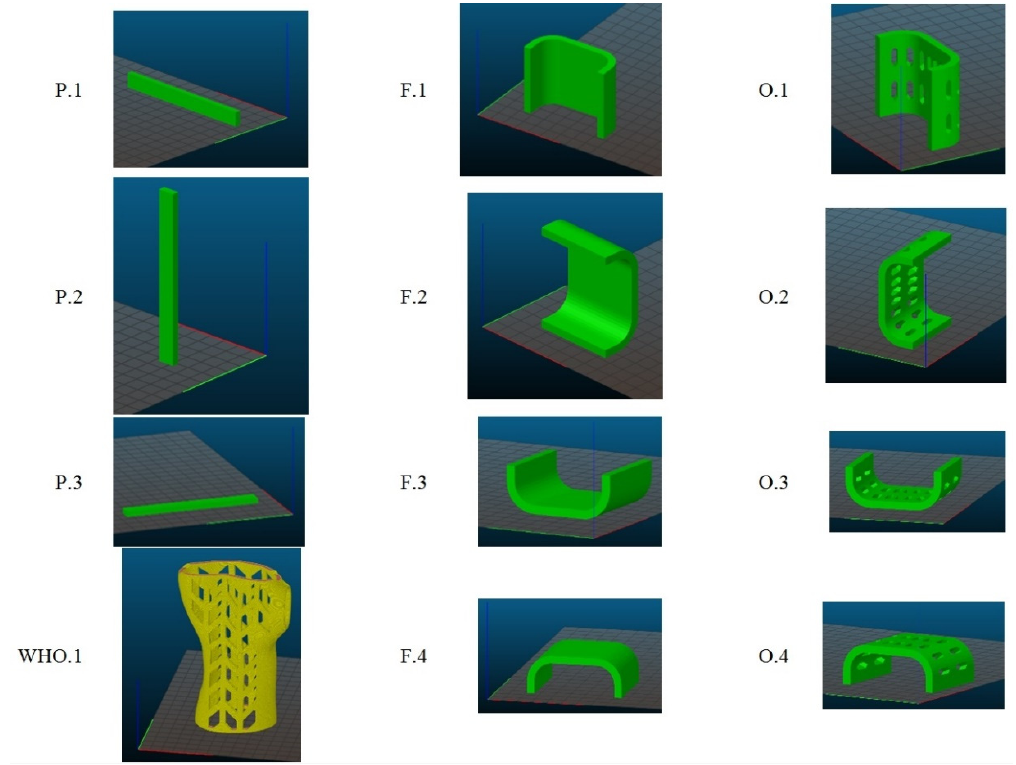
Figure 2. Designation of a series of samples and their arrangement in the working chamber.